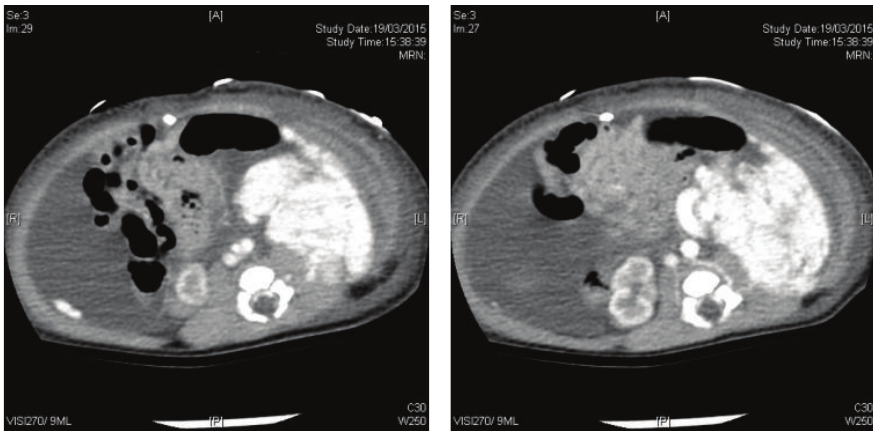
Figure 2: Postnatal CT scan showed a large multilobulated enhancing